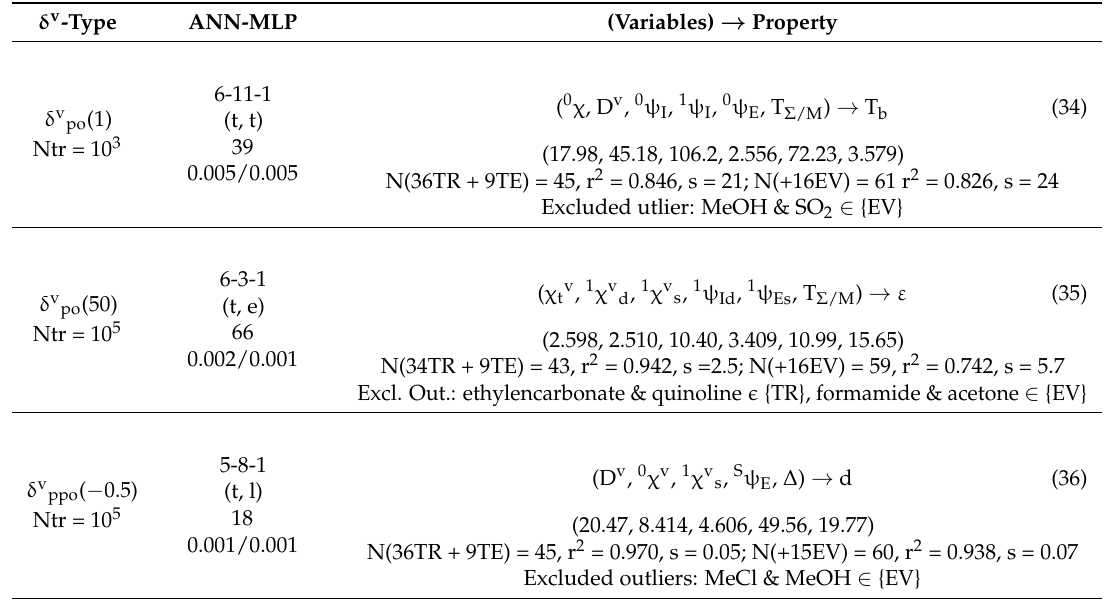
Table 7. ANN-MLP results with the number of hidden neurons chosen by Statistica 8. Descriptors are those of Table 4. The structure is similar to that in Table